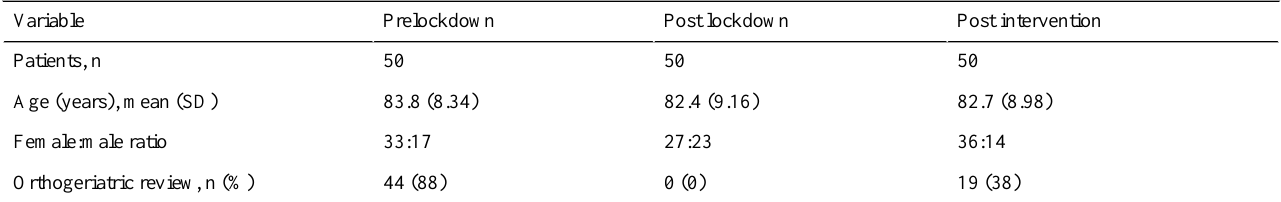
Table 1. The demographics of patients with femoral neck fractures whose data were analyzed for this study. The mean ages, the female:male ratio, and the number and percentage of patients who received an orthogeriatric review are shown.